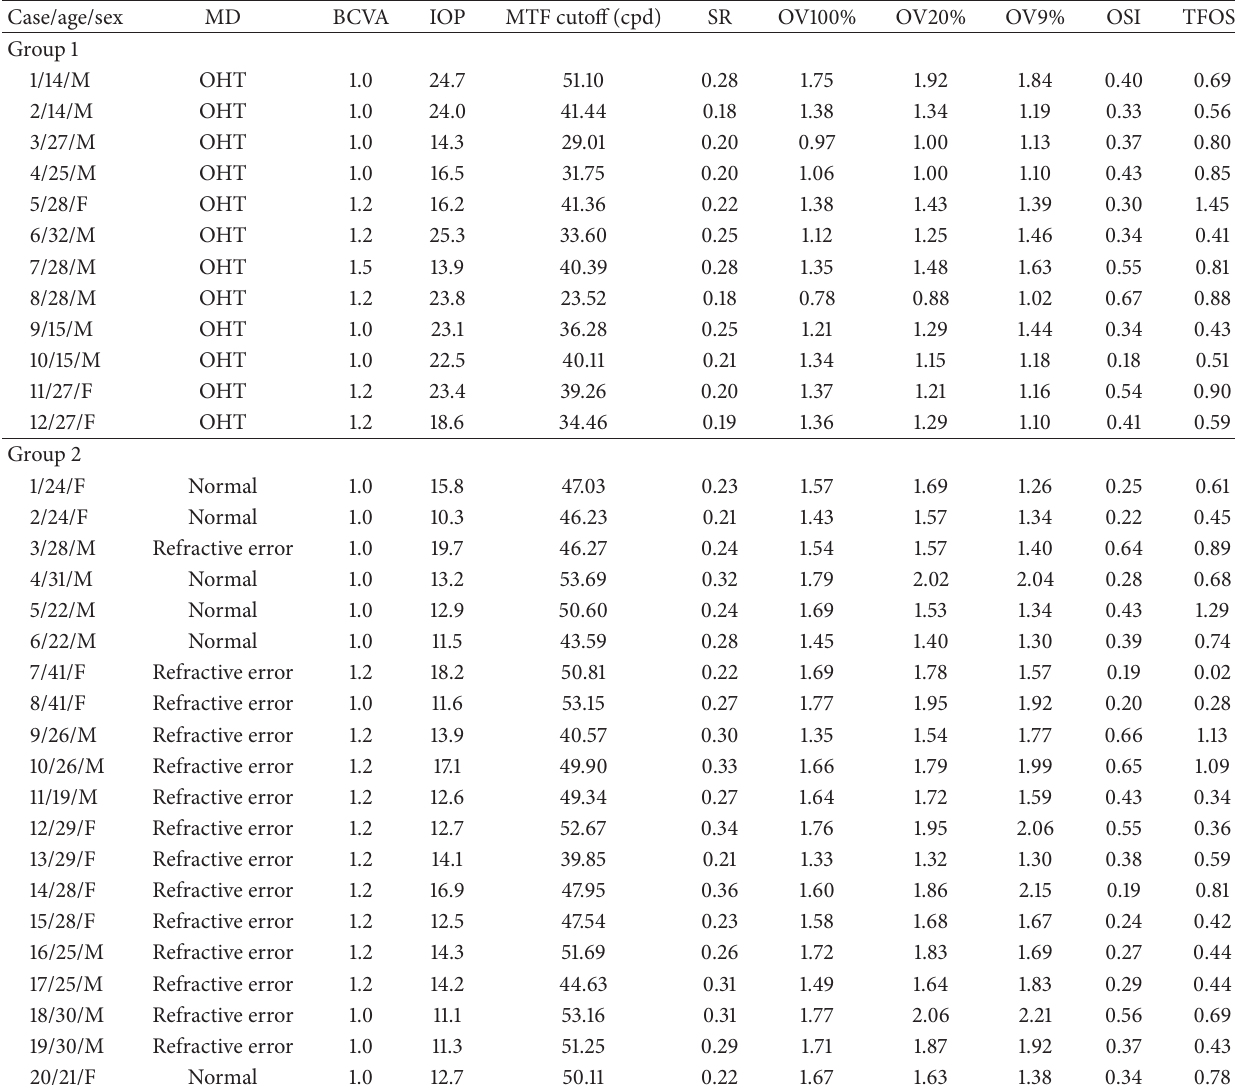
Table 1: Clinical characteristics of patients.